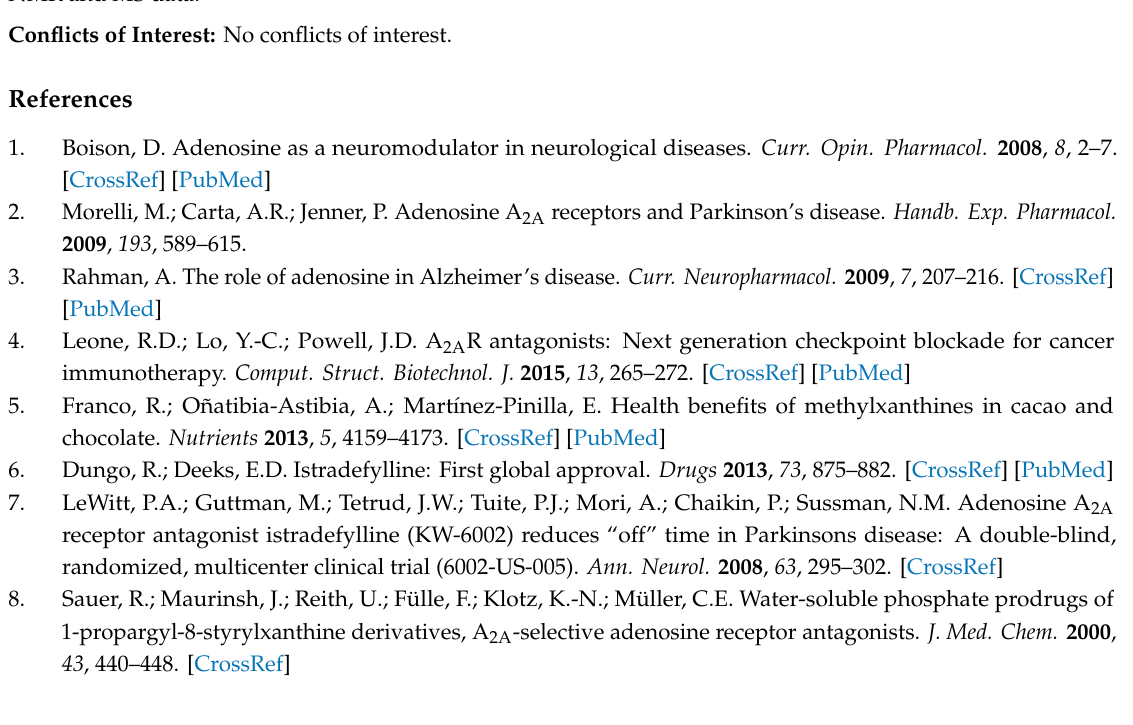
Supplementary Materials: The following data are available online. Figure S1–S15: NMR spectra, Figure S16: DHPLC analyses of 12 at 205 nm, Figure S17: UV-spectrum of compound 12 . Table S1–S3: Crystal data and structure refinement for compound 8 . Scheme S1–S2: Synthesis of diaminouracil